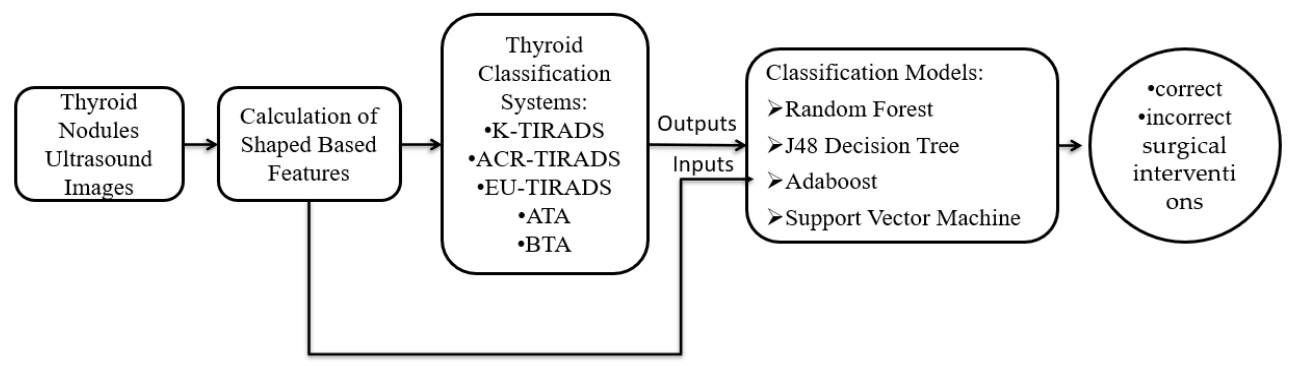
Figure 1. Flow diagram of proposed algorithm. Figure 1 . Flow diagram of proposed algorithm .